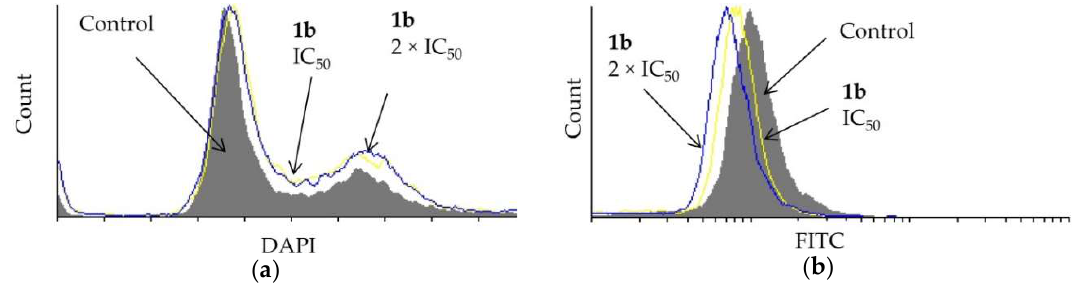
Figure 4. Effect of dendrimer 1b at IC 50 and 2 × IC 50 concentrations (72 h) on PC-3 cells on ( a ) cell cycle distribution and ( b ) cell division.